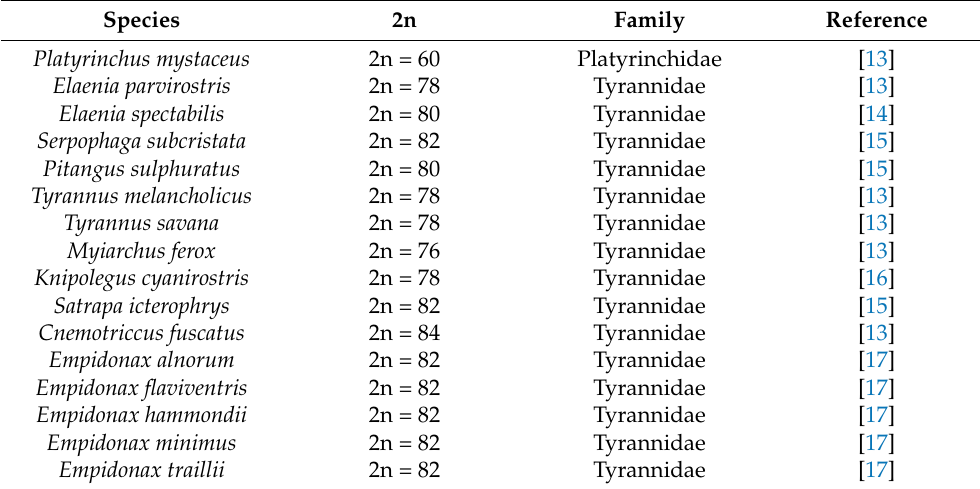
Table 1. Available cytogenetic data for species of Tyrant Flycatchers and related families (classification according to the relationships found by Harvey et al.